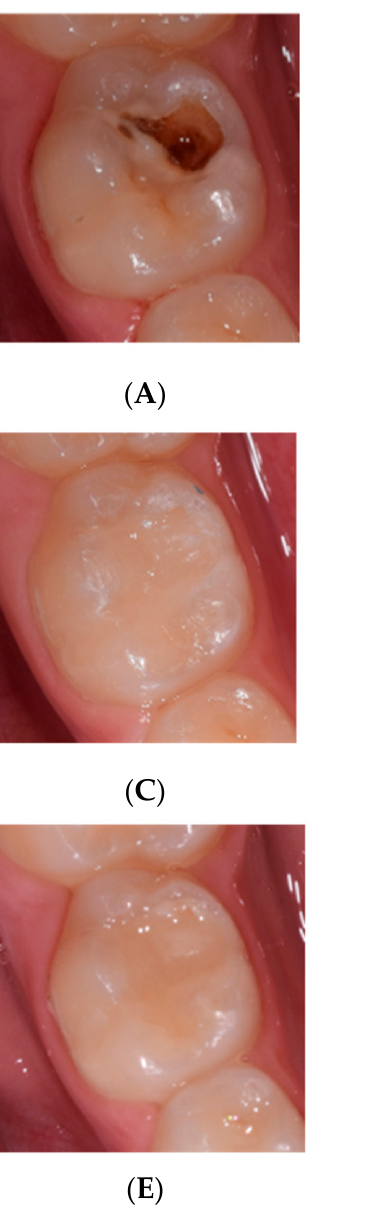
Figure 1. Example of a clinical case in which Activa BioActive was used. ( A ) pre operatory photograph, ( B ) pre operatory radiography, ( C ) post operatory, ( D ) 3 months post operatory, ( E ) 6 months post operatory and ( F ) 1 year follow up.